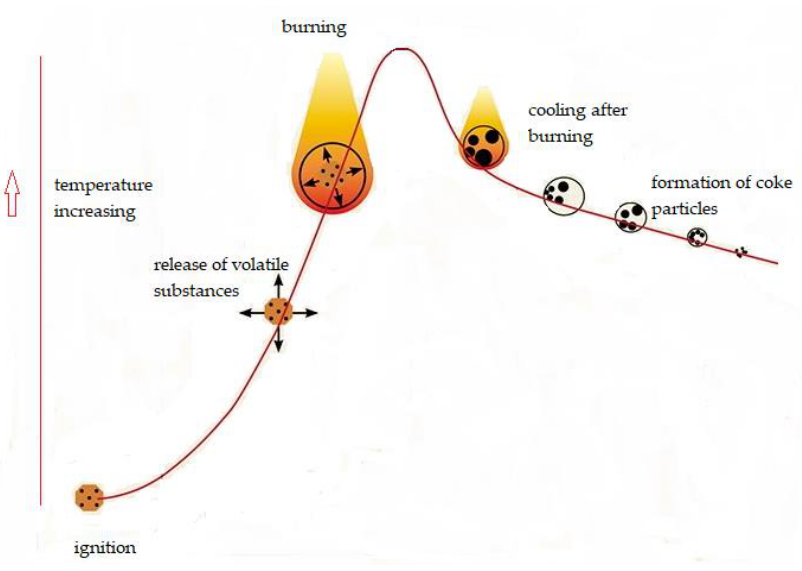
Figure 1. Combustion of a coal particle.